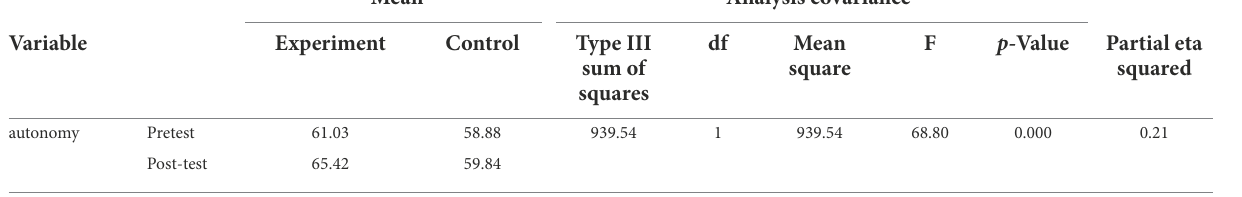
TABLE 6 Results of analysis of covariance for